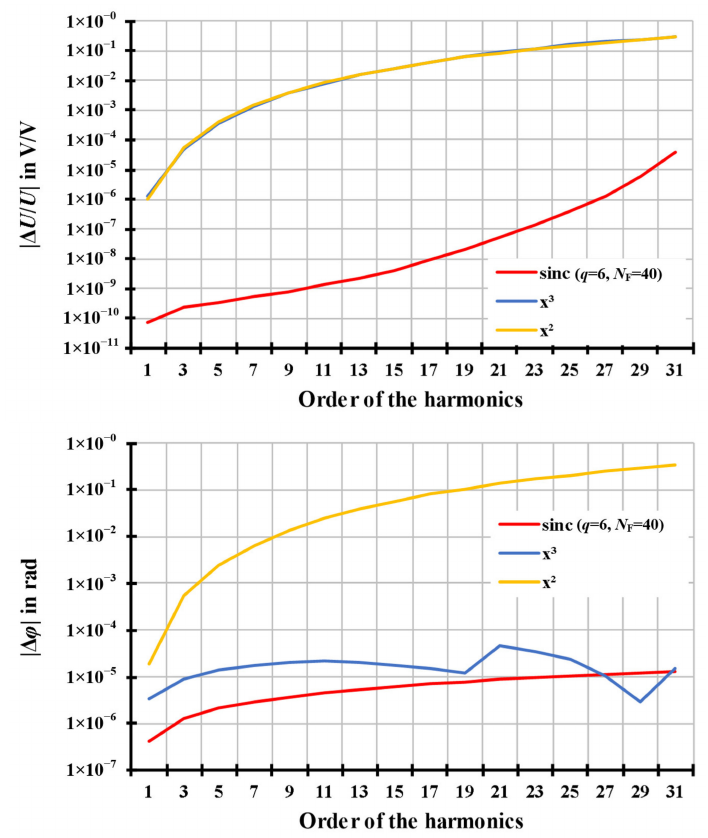
Figure 10. The resampling amplitude and phase error of a square waveform signal. The signals are simulated with parameters of f S = 4000 Hz, T W = 1 s, U 1 = 1 V, f 1 = 50.1 Hz, ϕ 1 = 0 ◦ , U H = 1 / (2 h + 1) · U 1 , f H = (2 h + 1) · f 1 , and ϕ H = 0 ◦ , where h is an integer and h = 0, 1, 2, ... , 15, without noise signal. The orange curves represent the results of the interpolation based on the quadratic function. The blue curves represent the results of the interpolation based on the cubic function. The red curves represent the results of the